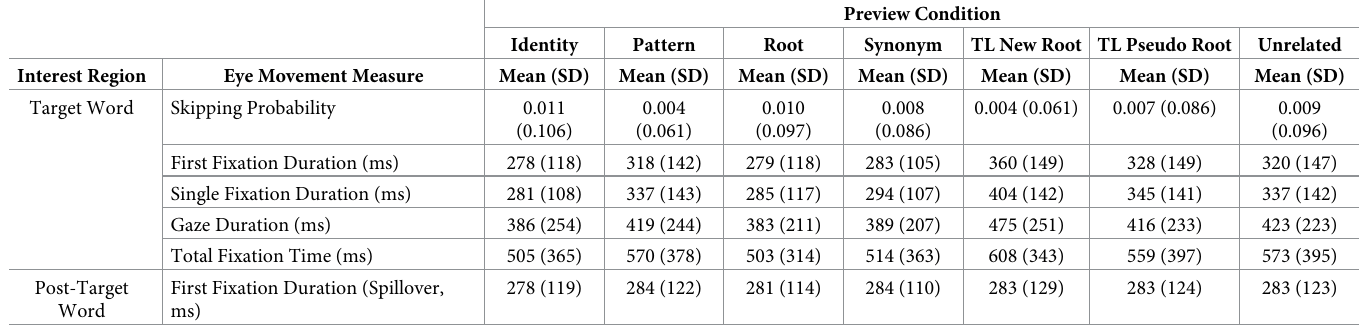
Table 2. Descriptive statistics of eye movement measures for the target and post-target